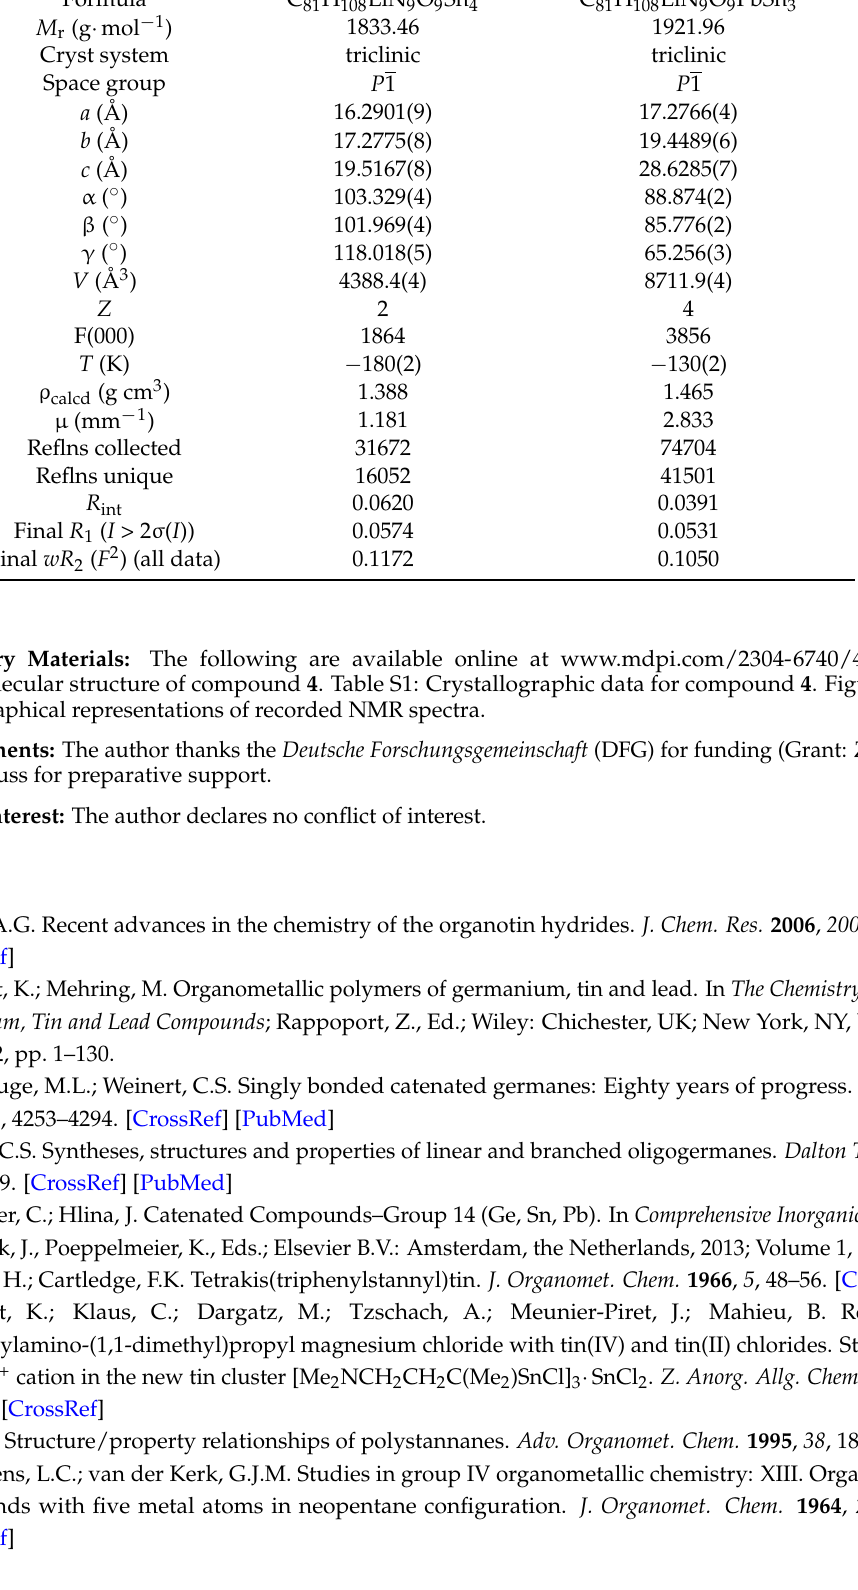
Table 2. Crystallographic data for compounds 2 and 3 .